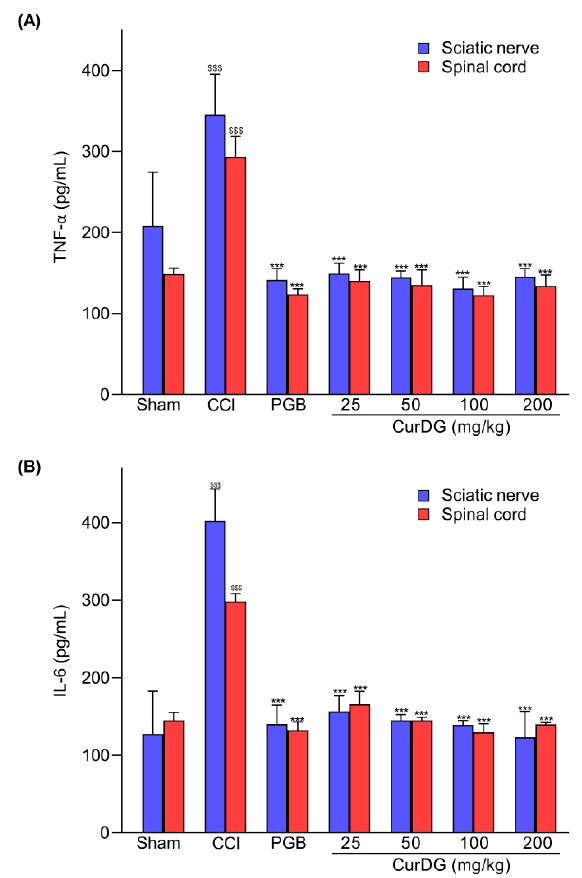
Figure 5. The increased TNF ‐α and IL ‐ 6 levels in CCI ‐ mice were diminished after the administration of CurDG (25, 50, 100, 200 mg/kg). ( A ) TNF α and ( B ) IL ‐ 6 expression in both the spinal cord and sciatic nerve. (Means ± SEM; $$$ and *** indicate the statistical significance at p < 0.001 compared to the sham group and the vehicle ‐ treated groups, respectively).